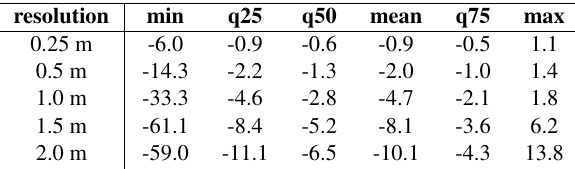
Table 2: Summary of relative errors of the volume calculation for the original method. [%]